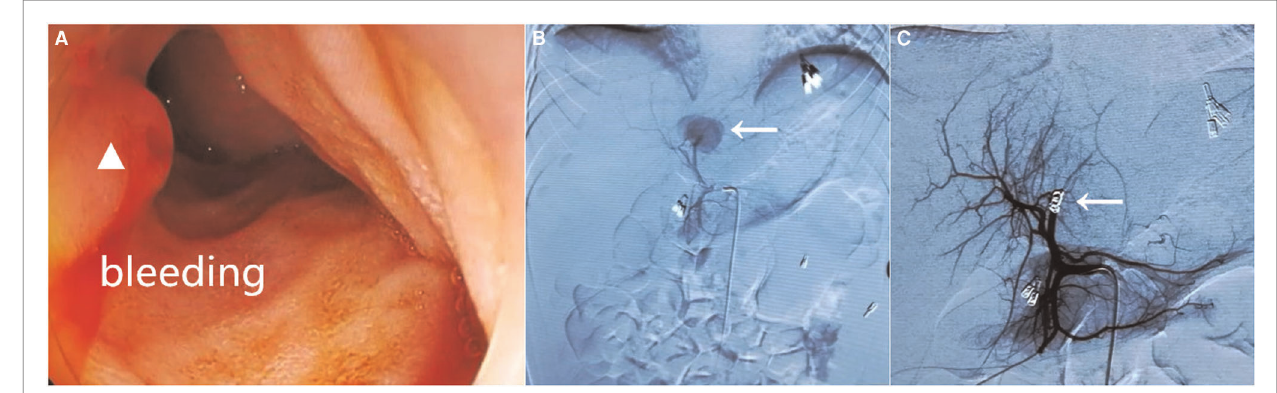
FIGURE 2 | Gastroduodenoscopy revealing active bleeding with fresh blood from the duodenal papilla (white triangle) ( A ). Hepatic arteriography showed contrast extravasation from the branch of the left hepatic artery (white arrow) ( B ) and selective transcatheter arterial embolization was successfully implemented ( C , white